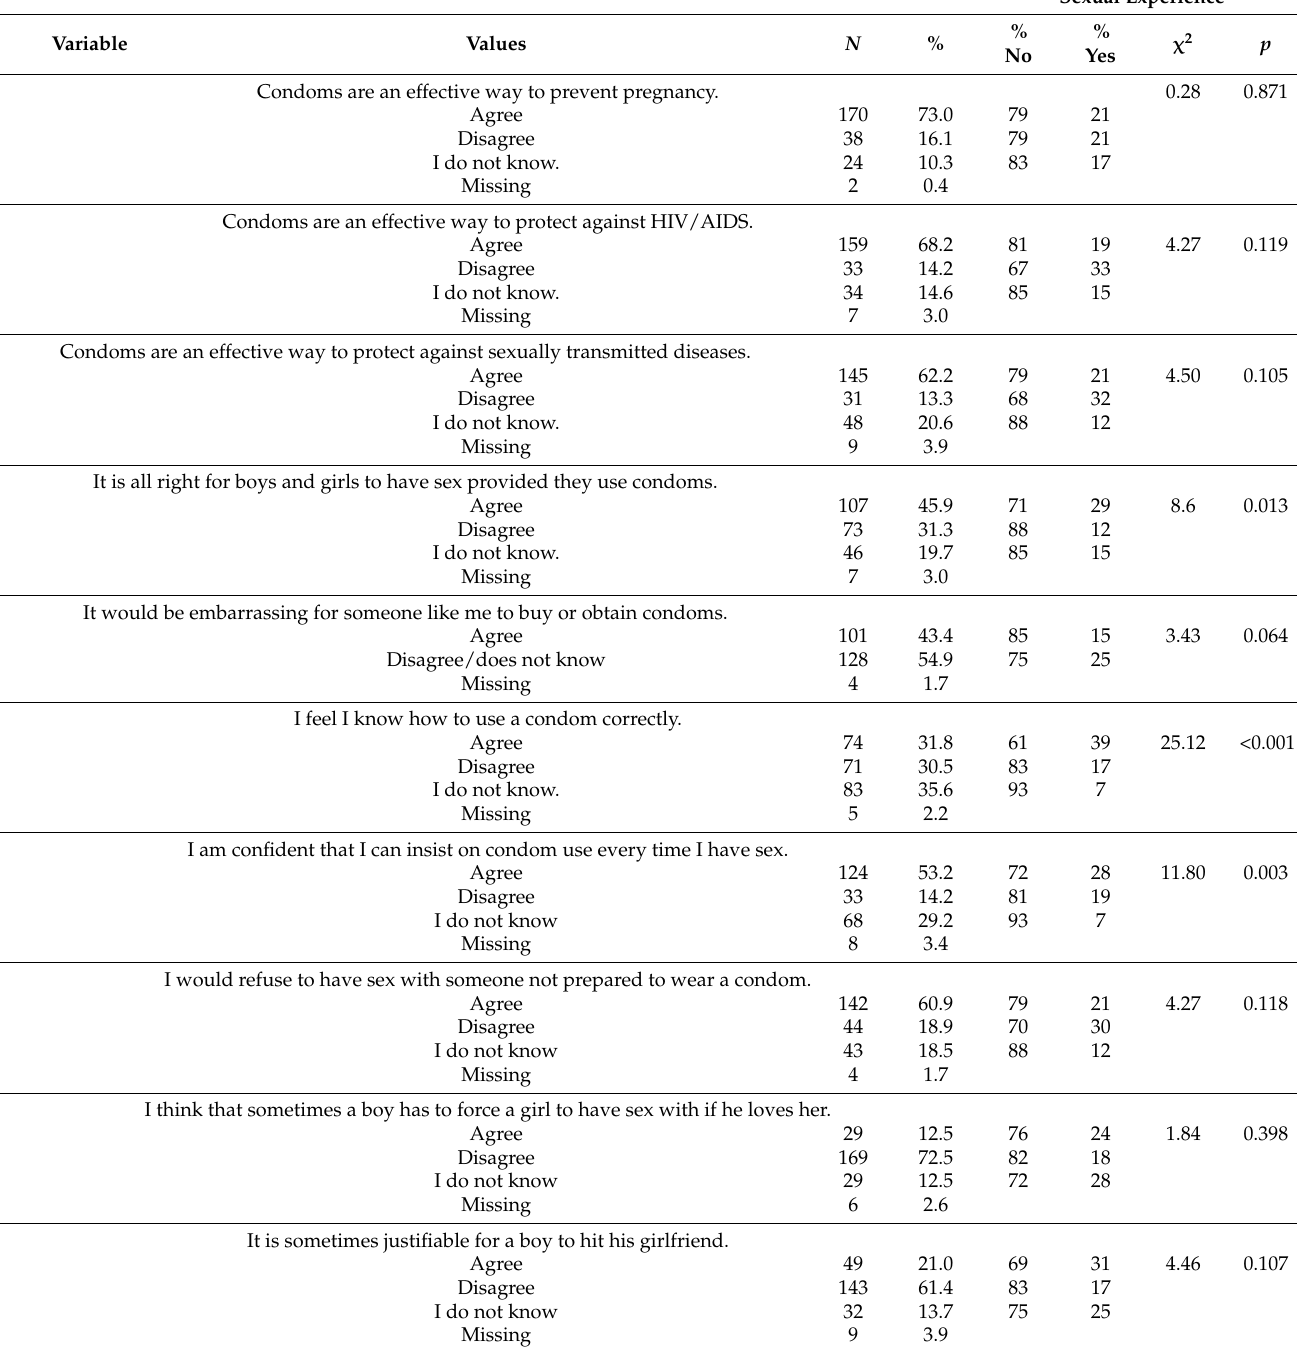
Sexual Experience % % χ 2 p No Yes